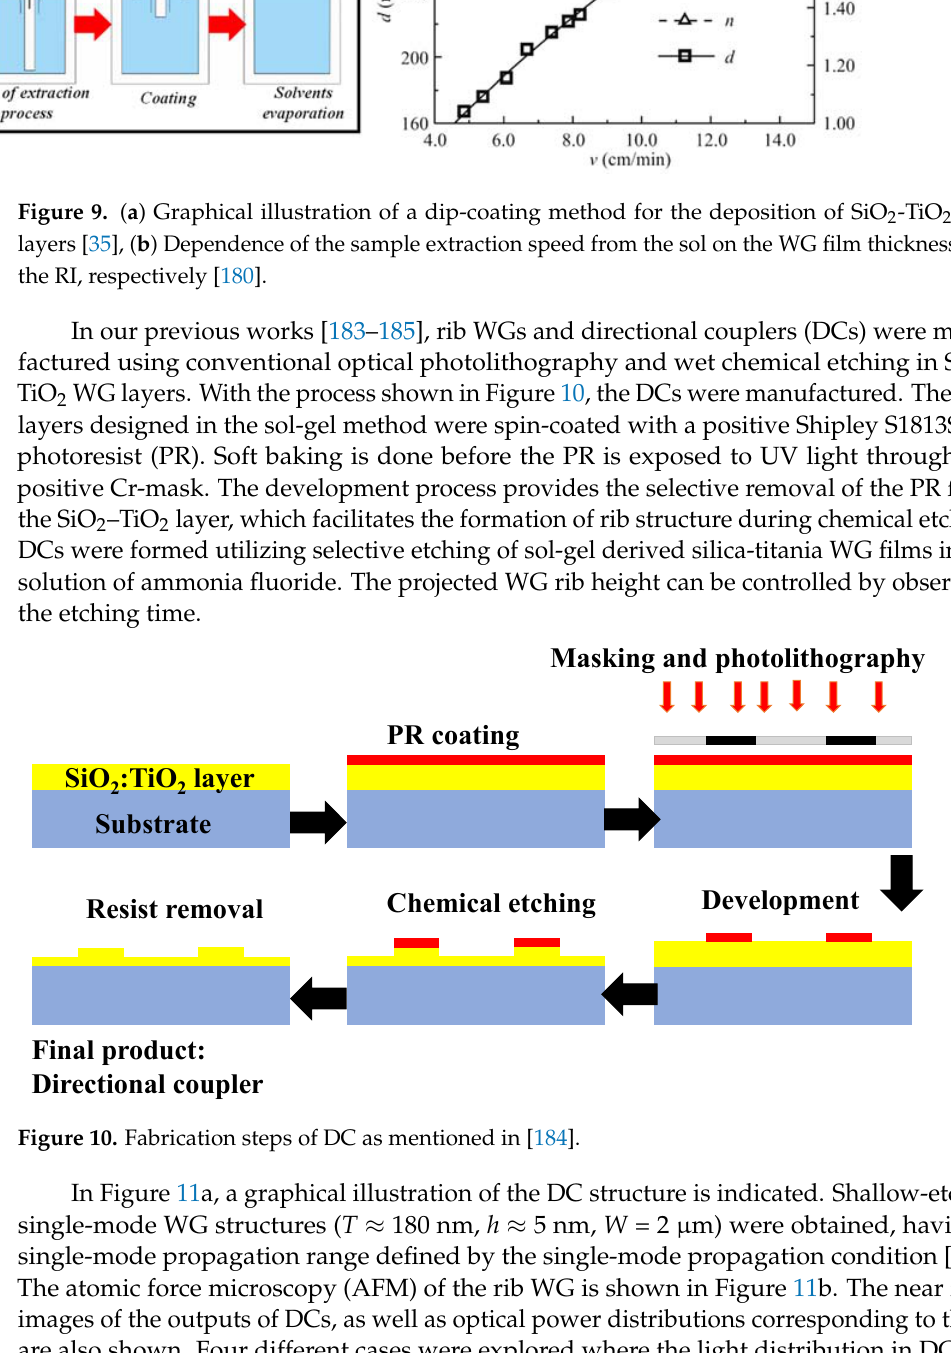
Figure 11. ( a ) Cross-sectional view of the directional coupler based on SiO 2 -TiO 2 platform, ( b ) Atomic force microscopy of the rib WG. Adapted with permission from [184]. Near-field image of a 1 × 2 DC and related distributed optical power when the coupling length ( L ), ( c ) 1.5 mm, ( d ) 3.0 mm, ( e ) 3.0 mm, ( f ) 4.5 mm. Adapted with permission from [184]. 4. Future Goals and Challenges The research on the silica-titania platform demonstrates extraordinary attributes such as low-cost WG technology development, low transmission loss, and chemical resistance to oxidation [186]. This opens up the doors for this technology to compete with the existing mainstream integrated photonics platforms, especially in low-volume niche applications such as sensing [187]. The silica-titania PIC technology was designed from the start to be a low-cost option for possible application by SMEs or less-developed research organizations. In comparison to mainstream technology, the proposed innovation can save money on three fundamental steps: (a) WG film procurement (using gaseous phase film deposition, such as LPCVD in the case of SiN and InP, or ordering SOI